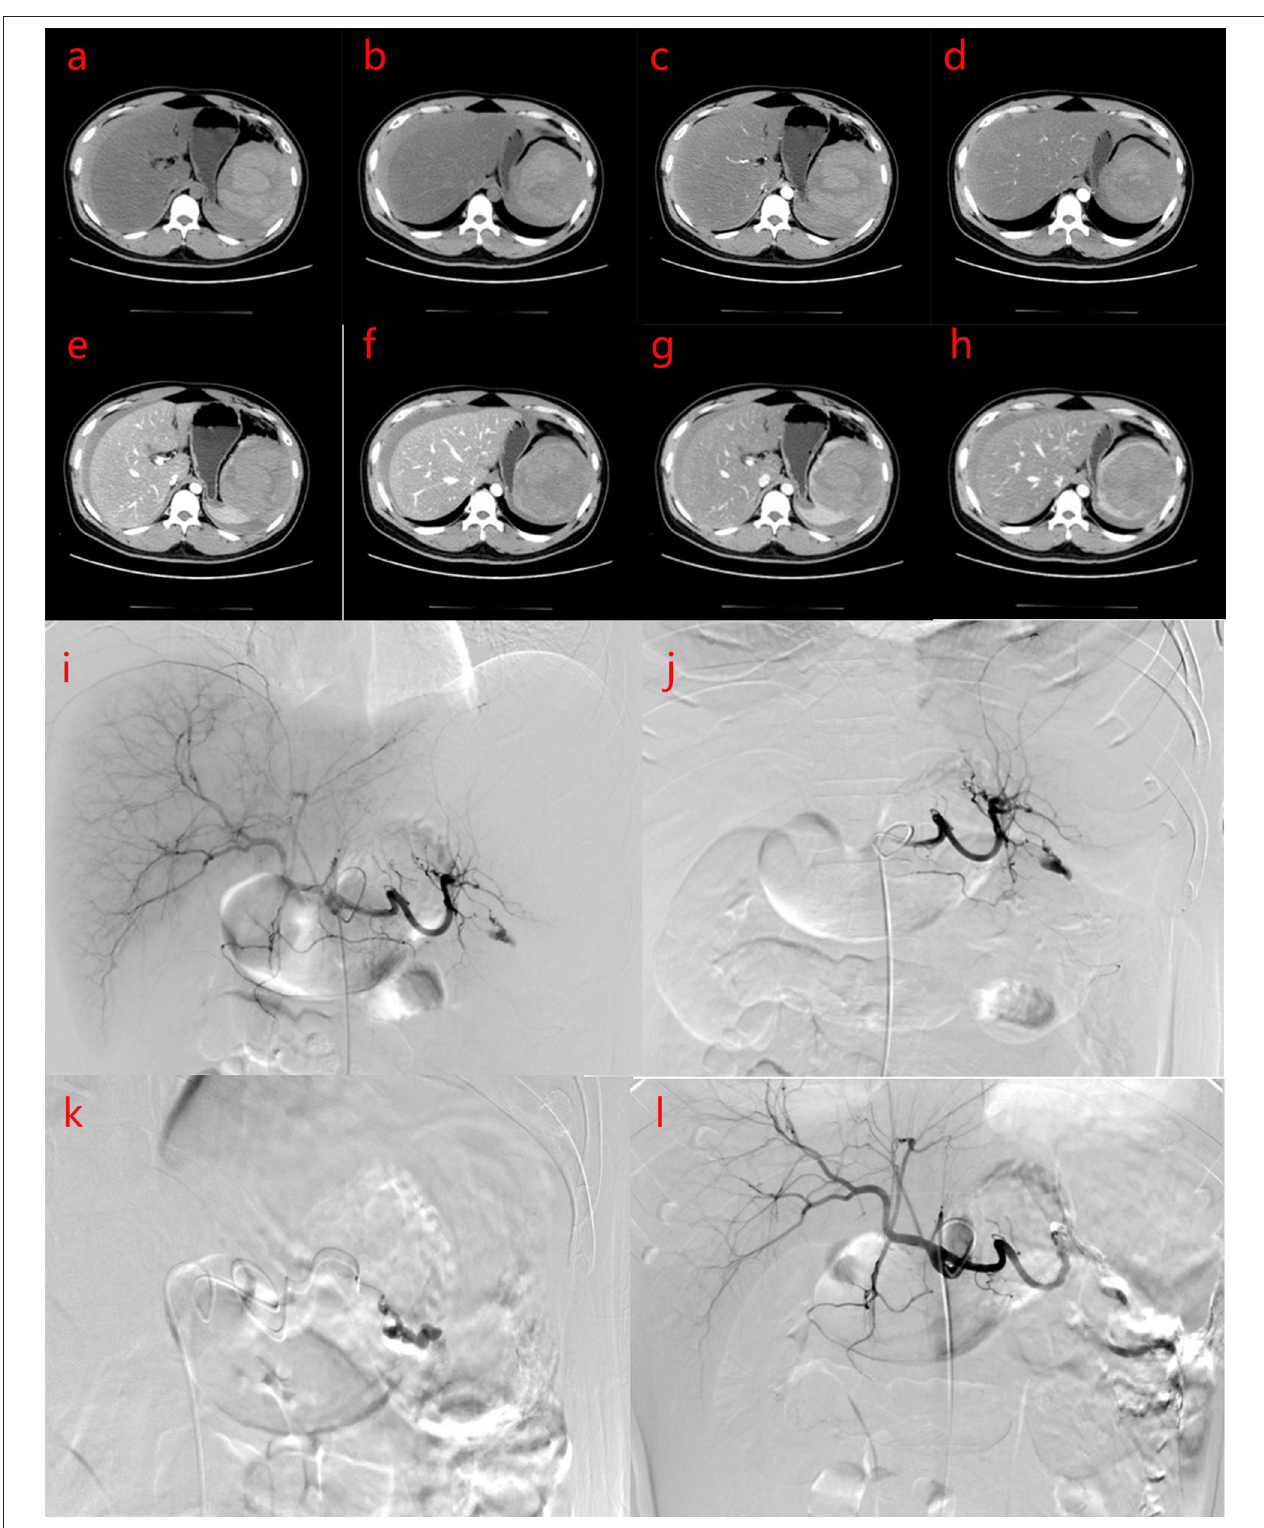
FIGURE 1 | (a–h) Plain computed tomography (CT) scan and enhancement of the upper abdomen CT before intervention shows that the density of liver parenchyma is significantly reduced, and the shadow of intrahepatic vessels shows relative density on plain CT scan. The spleen is enlarged, and there is a mixed density shadow in the spleen with a size of about 10.0 × 8.8 × 12.5cm. The plain CT value is about 11–67 HU, the boundary is unclear, and the enhanced CT shows partly obvious